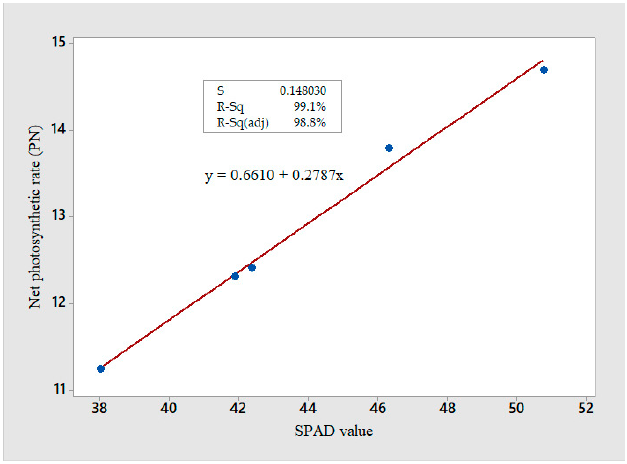
Figure 4. This graph shows the positive correlation between SAPD value and net photosynthetic rate which means that increases SPAD value has efficiently improved the photosynthetic rate. CA is a zinc-containing metalloenzyme that converts free atmospheric CO 2 into HCO 3 at the initial stages of photosynthetic reactions [48] and is also involved in various biological functions such as photosynthesis, ion exchange, respiration, and acid-base buff-